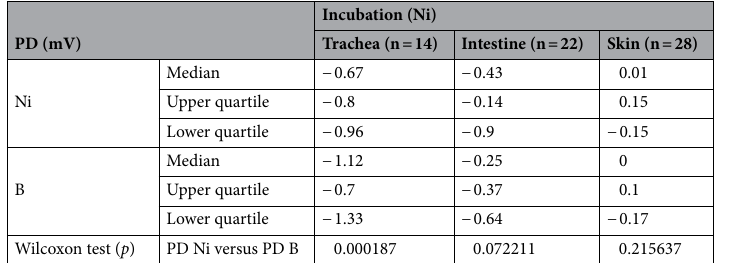
Table 6. Transepithelial electric potential (PD) of the trachea, intestine and skin specimens measured in stationary conditions at the end of experiments and treated with nickel chloride (0.1 mM) and bumetanide (0.1 mM). The values of medians and lower and upper quartiles are given. Abbreviations: B—bumetanide (0.1 mM) solution, Ni—nickel chloride (0.1 mM) and bumetanide (0.1 mM) solution, PD—transepithelial potential difference of the tissue surface (mV) measured in stationary conditions after 75 min, p < 0.05.